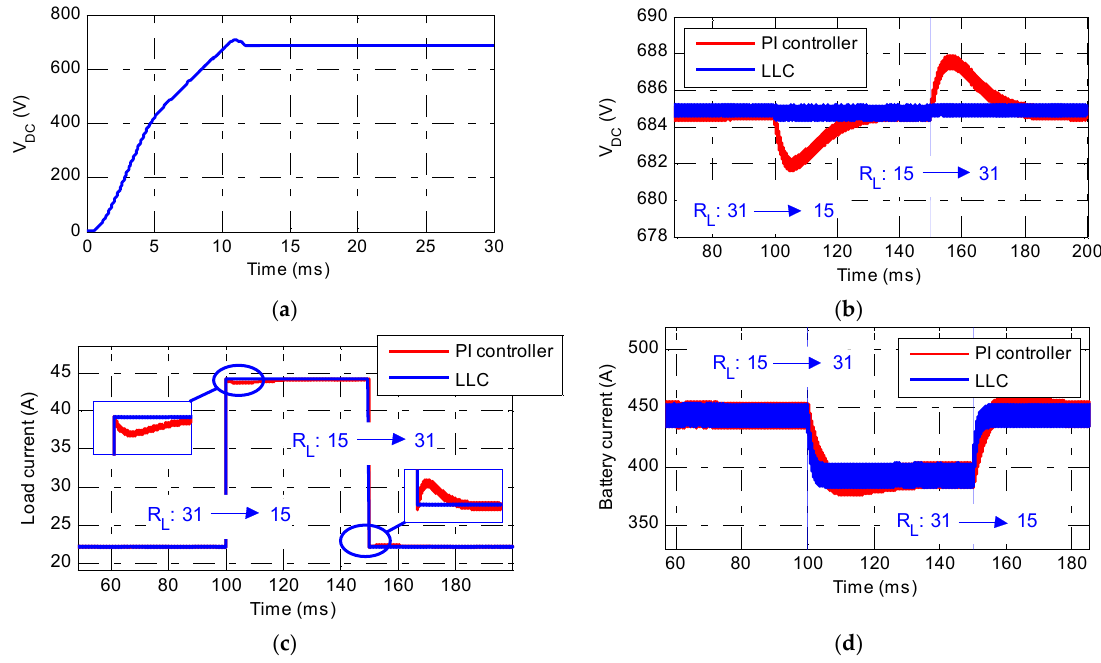
Figure 9. ( a ) Step response of the proposed LLC for the bidirectional converter; ( b ) response to load resistance variations; ( c ) load current during load resistance variation; and ( d ) battery current during load resistance variations. Table 5. Comparison of the Step Response for the Bidirectional Converter.